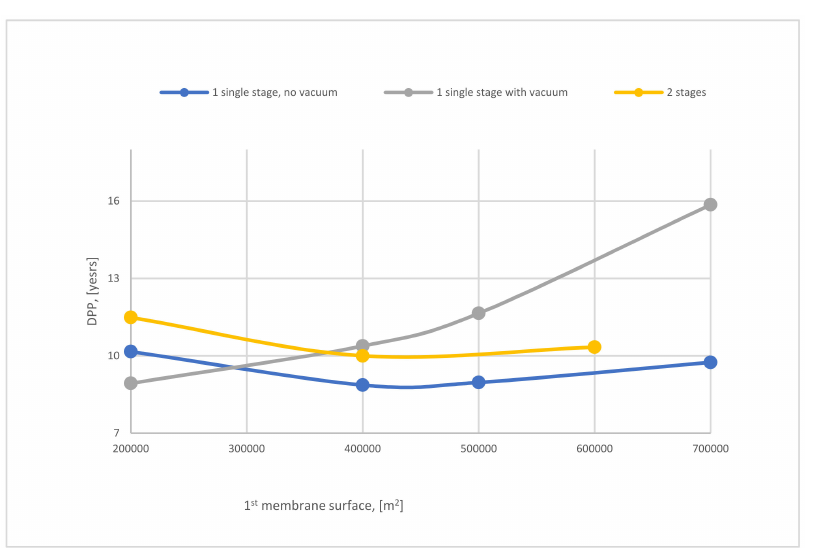
Figure 26. The variation of DPP of 1-stage (with and without VP) and 2-stage of the membrane at 8 bar CP 1 , 4 bar CP 2 , and 40,000 m 2 of SA 2